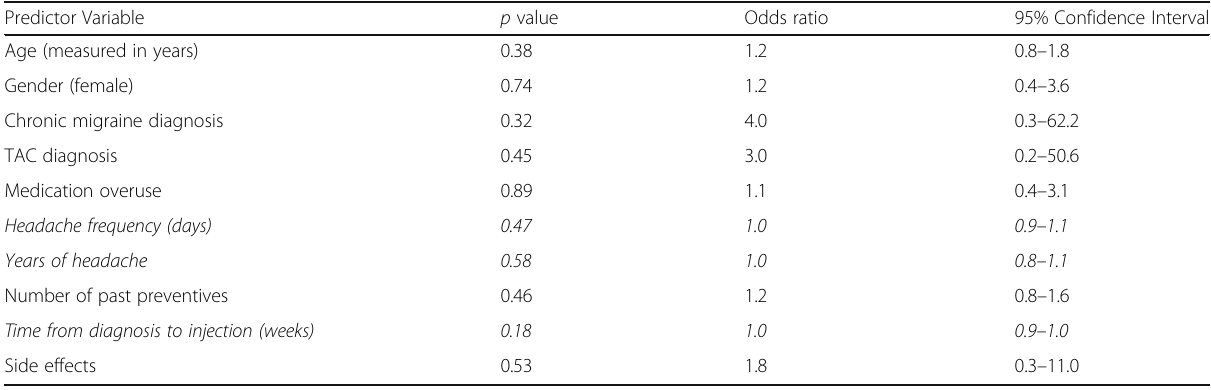
Table 3 Results of binary logistic regression analysis for likelihood of improvement from greater occipital nerve injection. Variables in italics were associated with negative beta values and therefore a decreased likelihood of the outcome Predictor Variable p value